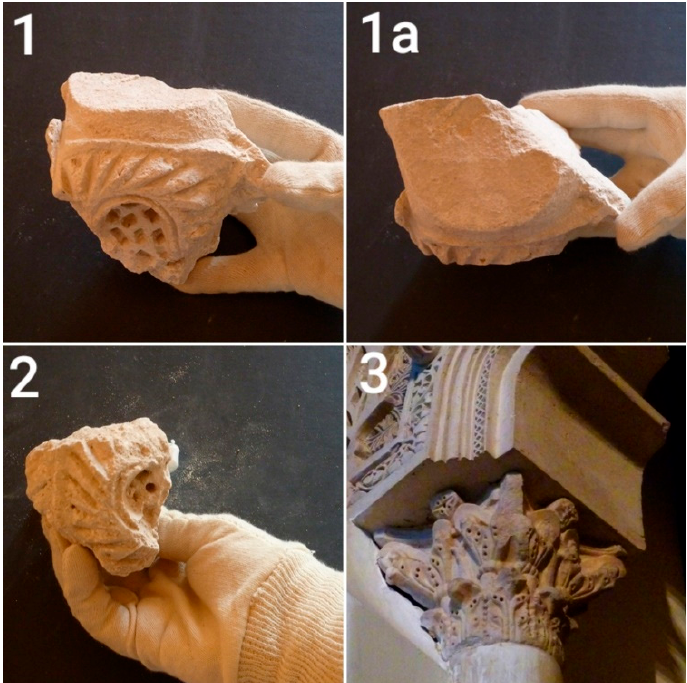
Figure 19 . Fragment of a small capital. ( 1 ) and ( 1a ) different views of the same piece, ( 2 ) fragment of Figure 19. Fragment of a small capital. ( 1 ) and ( 1a ) di ff erent views of the same piece, ( 2 ) fragment of a a leaf, ( 3 ) small capital from the heikhal of El Tránsito Synagogue. Used by permission leaf, ( 3 ) small capital from the heikhal of El Tr á nsito Synagogue. Used by The analysis of the decorative fragments suggests that the synagogue had a heikhal facade divided into three vertical panels in the same style of the fourteenth-century synagogues of El